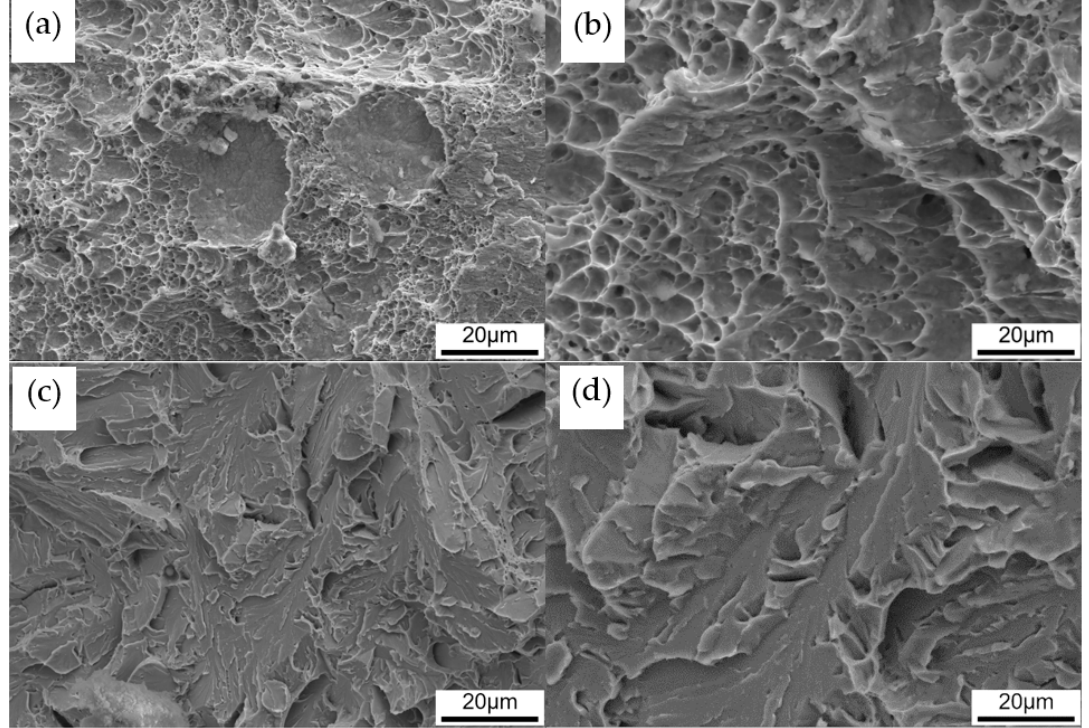
Figure 4. SEM morphology showing the fracture surface near the crack-initiation site of Charpy impact specimens of: A880 ( a , b ); and A1100 ( c , d ). Both specimens failed at − 100 °C.